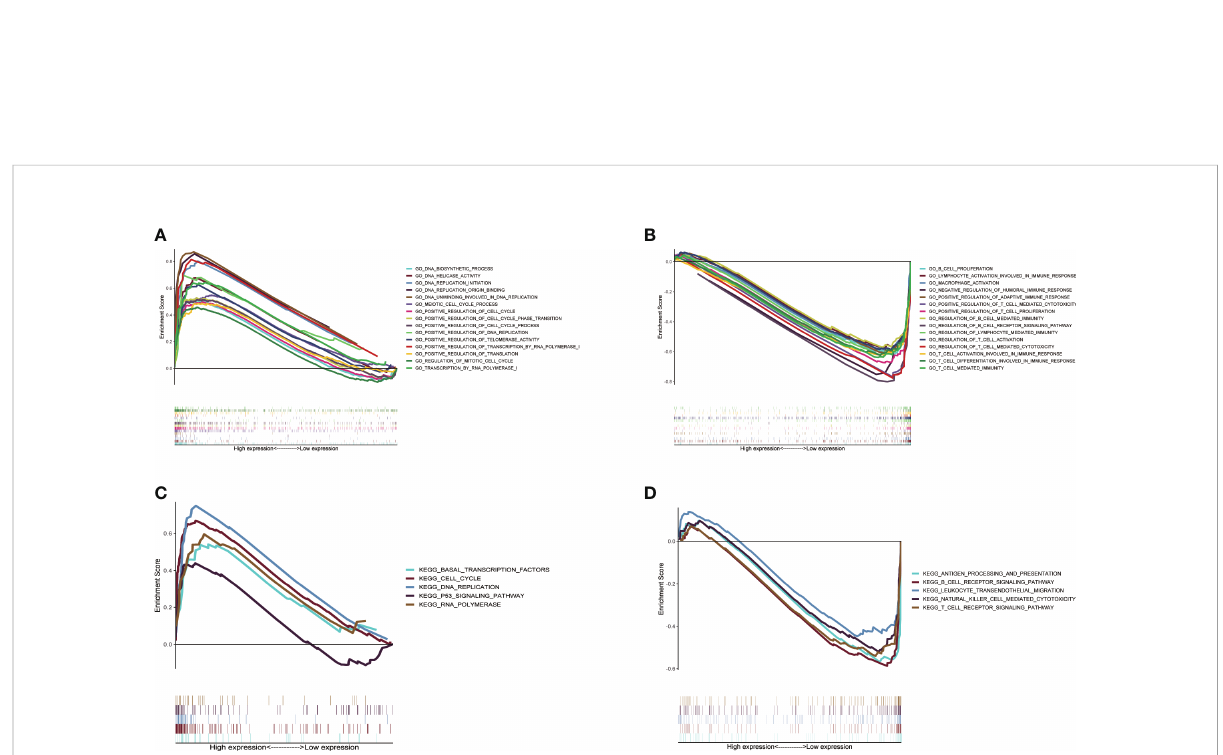
FIGURE 6 Gene set enrichment analysis between high- and low-risk groups based on LMRGS. Enrichment of GO in high-risk group (A) and low-risk group (B) . Enrichment of KEGG in high-risk group (C) and low-risk group (D)